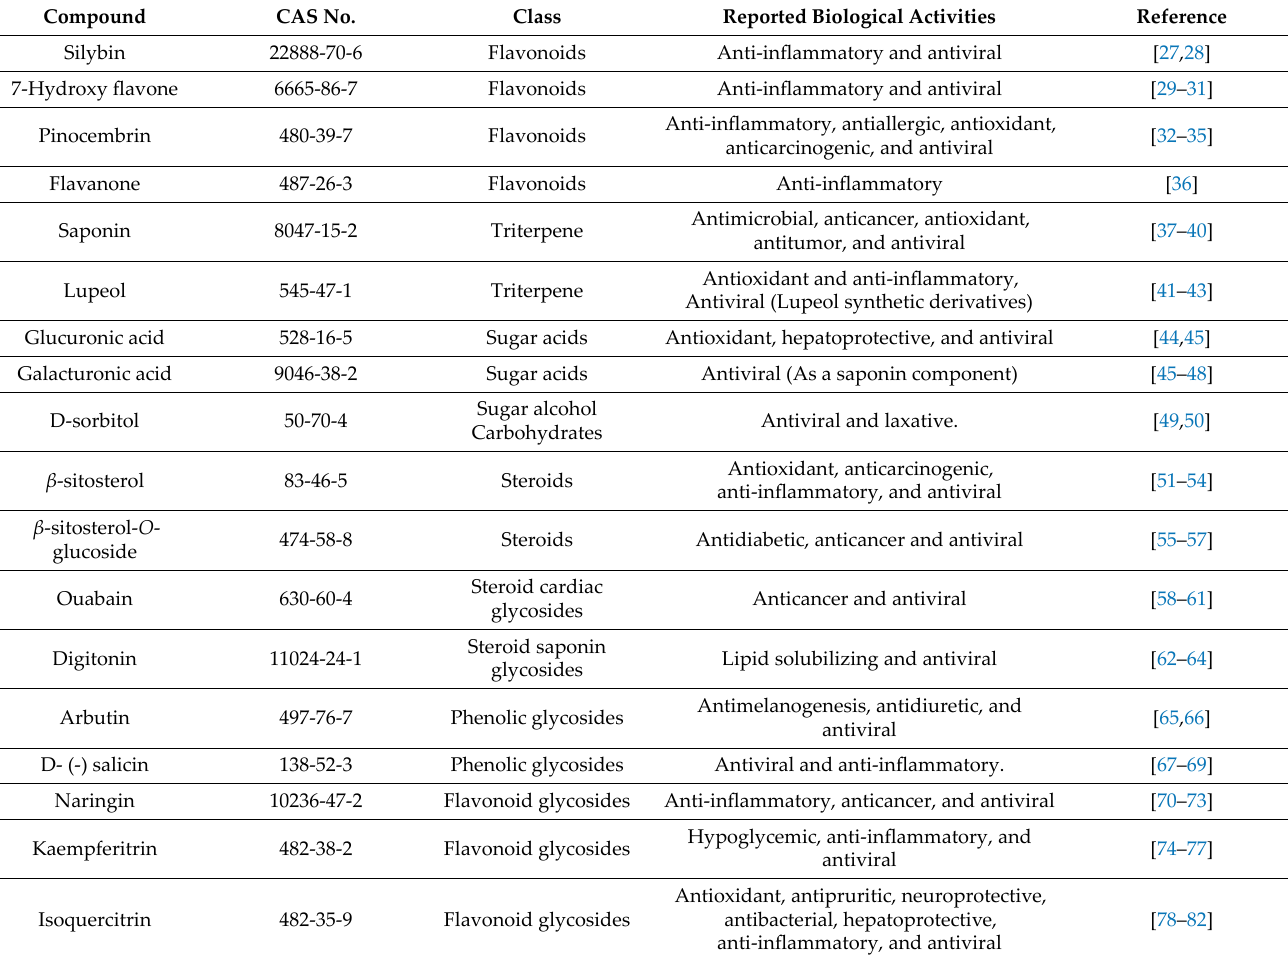
Table 1. The chemical classification and biological activities of the phytochemicals and drug control used in this